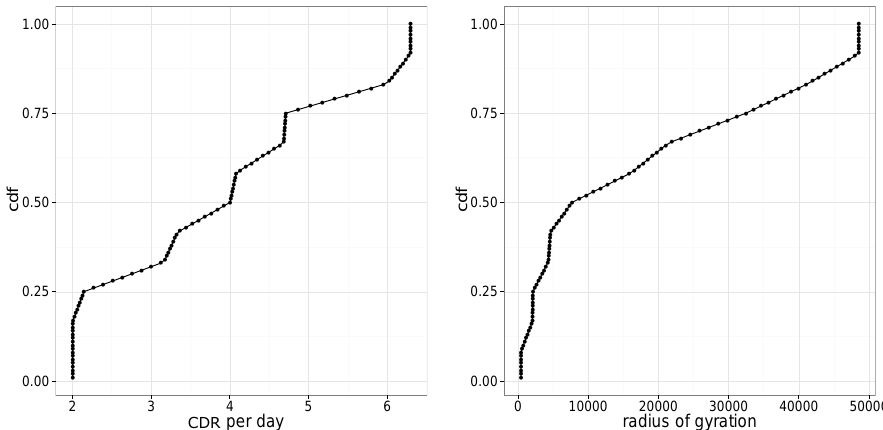
Figure 2. ( left ) Cumulative distribution (CDF) of CDRs per day. ( right ) CDF of radius of